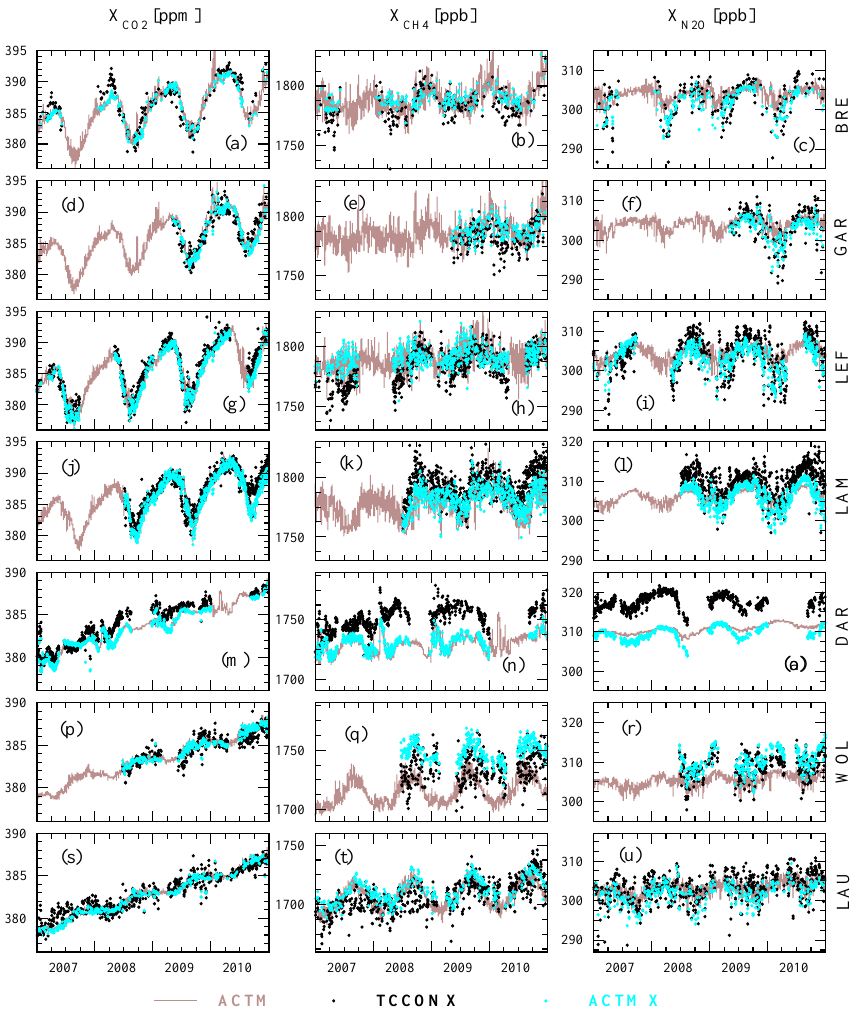
Fig. 4. Comparisons of TCCON measurement (black dots) and ACTM-simulation smoothed by averaging kernels and a priori profiles (blue dots) for X CO , X CH , and X N (from left to right panels) at seven selected sites (corresponding names marked on the right for each row). 2 4 2 O The observational records at the other operational TCCON sites are short or do not cover all three species. The brown line represents the original/unsmoothed ACTM continuous time series with a 3-hourly time step. Comparisons of X CO 2 , X CH 4 and X N 2 O from TCCON and ACTM are depicted for all measurement sites in Fig. S1, S2 and S3, respectively.